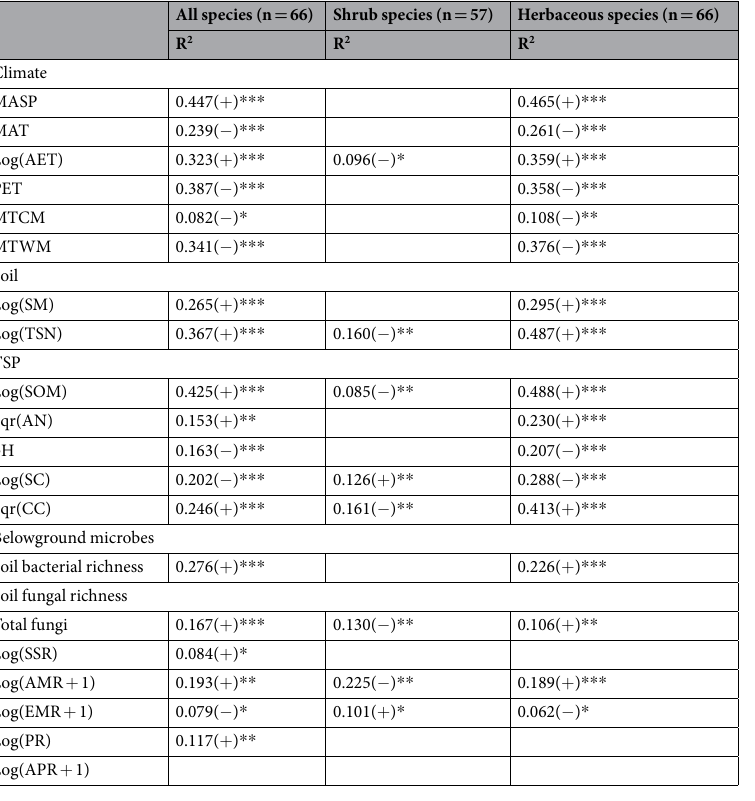
Table 3. Relationships between different environmental factors and LPSR. We defined the relationships between different environmental factors and species richness as follows: positive ( + ), negative ( − ). P -values are reported if their significance level is below 0.05. * P ≤ 0.05, ** P ≤ 0.01 and *** P ≤ 0.001. SM, soil moisture content; TSN, total nitrogen; TSP, total phosphorus; SOM, soil organic matter; AN, available nitrogen; SC, sand content; CC, clay content; MASP, mean annual summer precipitation; AET, actual evapotranspiration; MAT, mean annual temperature; PET, potential evapotranspiration; MTWM and MTCM, mean temperature of the coldest month and the warmest month, respectively; SSR, saprotrophic richness; PR, pathogenic richness; APR, animal parasitic richness; EMR, ectomycorrhizal richness; AMR, arbuscular mycorrhizal